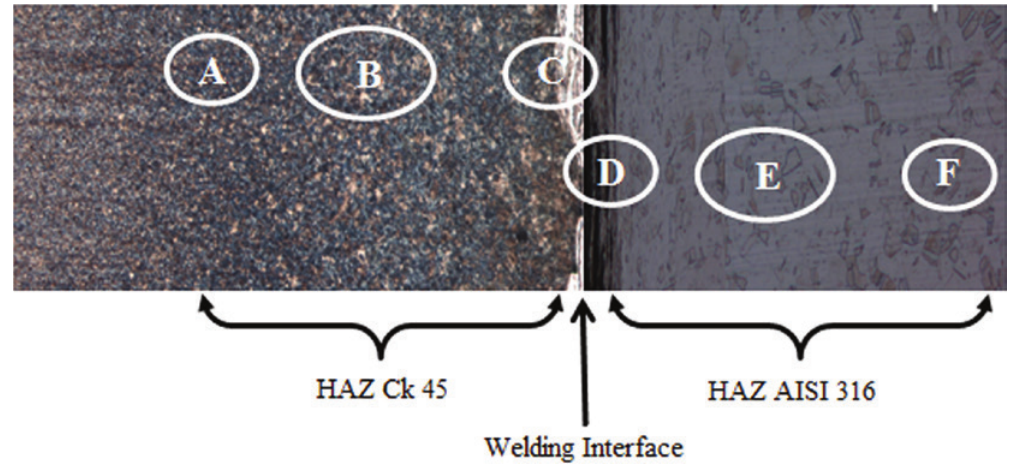
Fig. 5: Different zones of microstructure in the welded sample